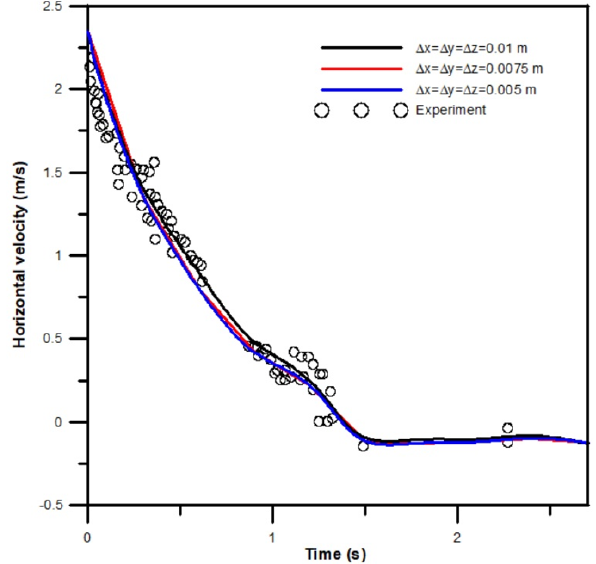
Figure 4. Time history of the horizontal velocity upstream the square obstacle at the location (0.754, 0, 0.026).